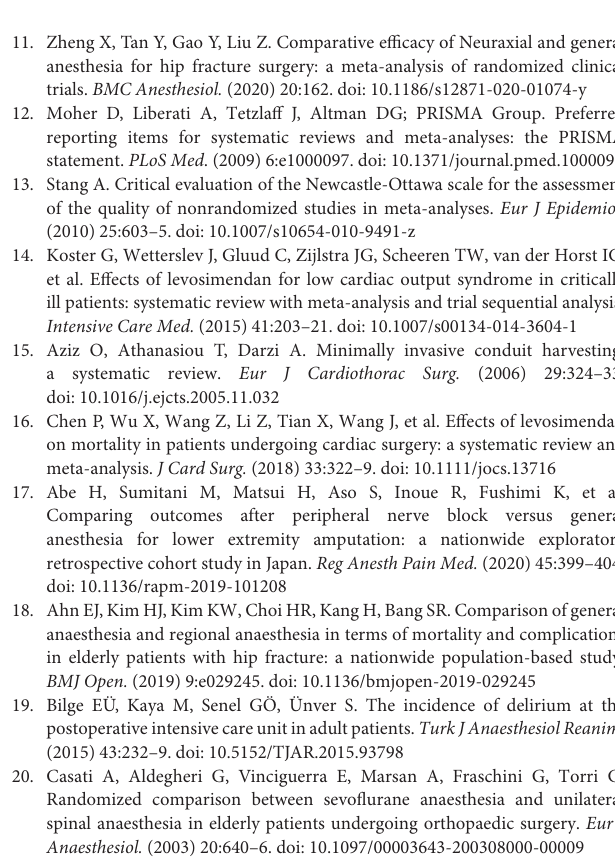
Supplementary Figure 2 | Risk of bias summary: review authors’ judgements about each risk of bias item for each included study. Supplementary Table 1 | The guidelines of the 2009 PRISMA (Preferred Reporting Items for Systematic reviews and